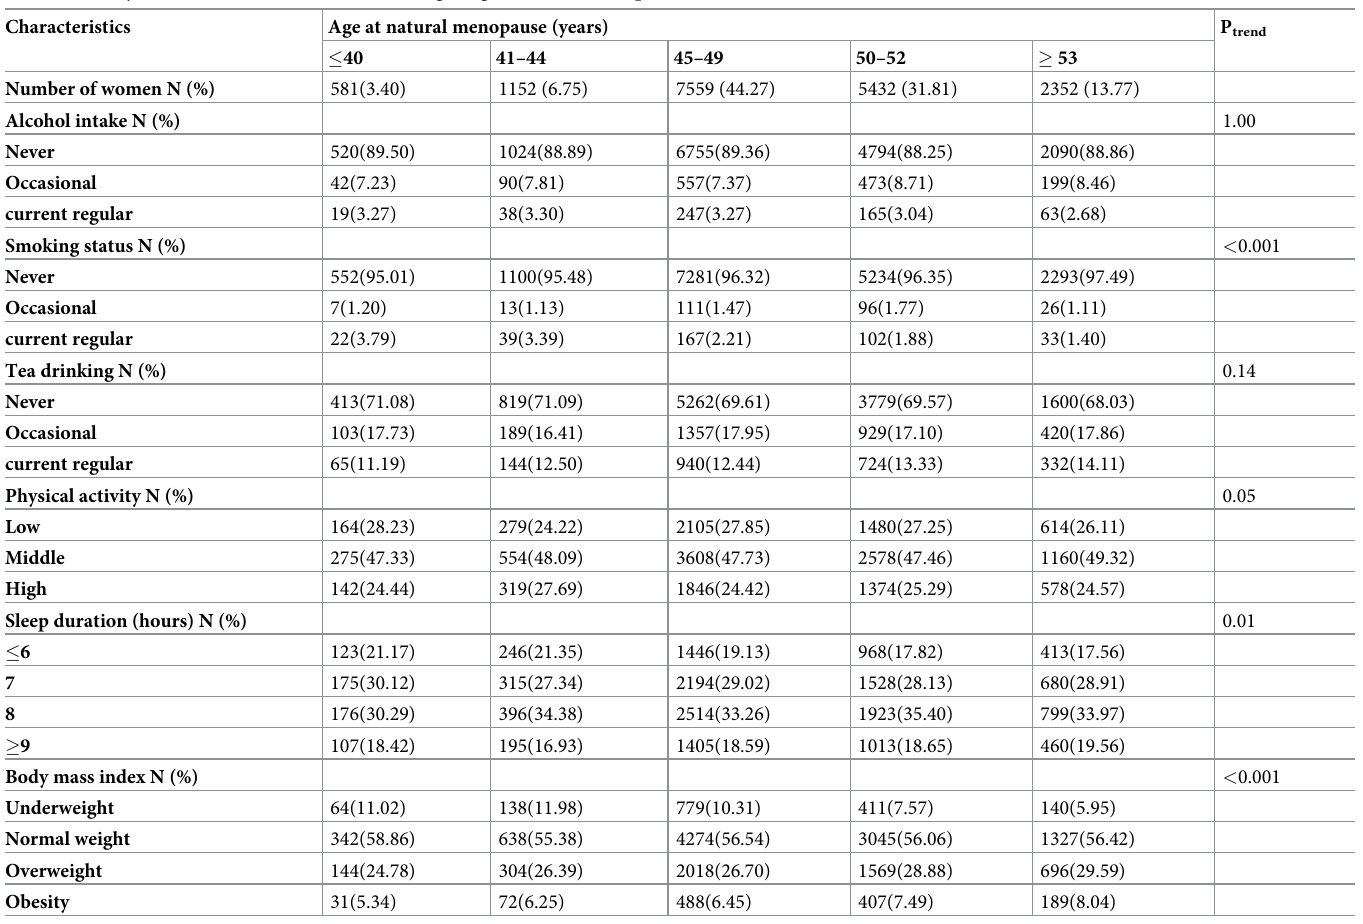
Table 2. Lifestyle characteristics of women according to age at natural